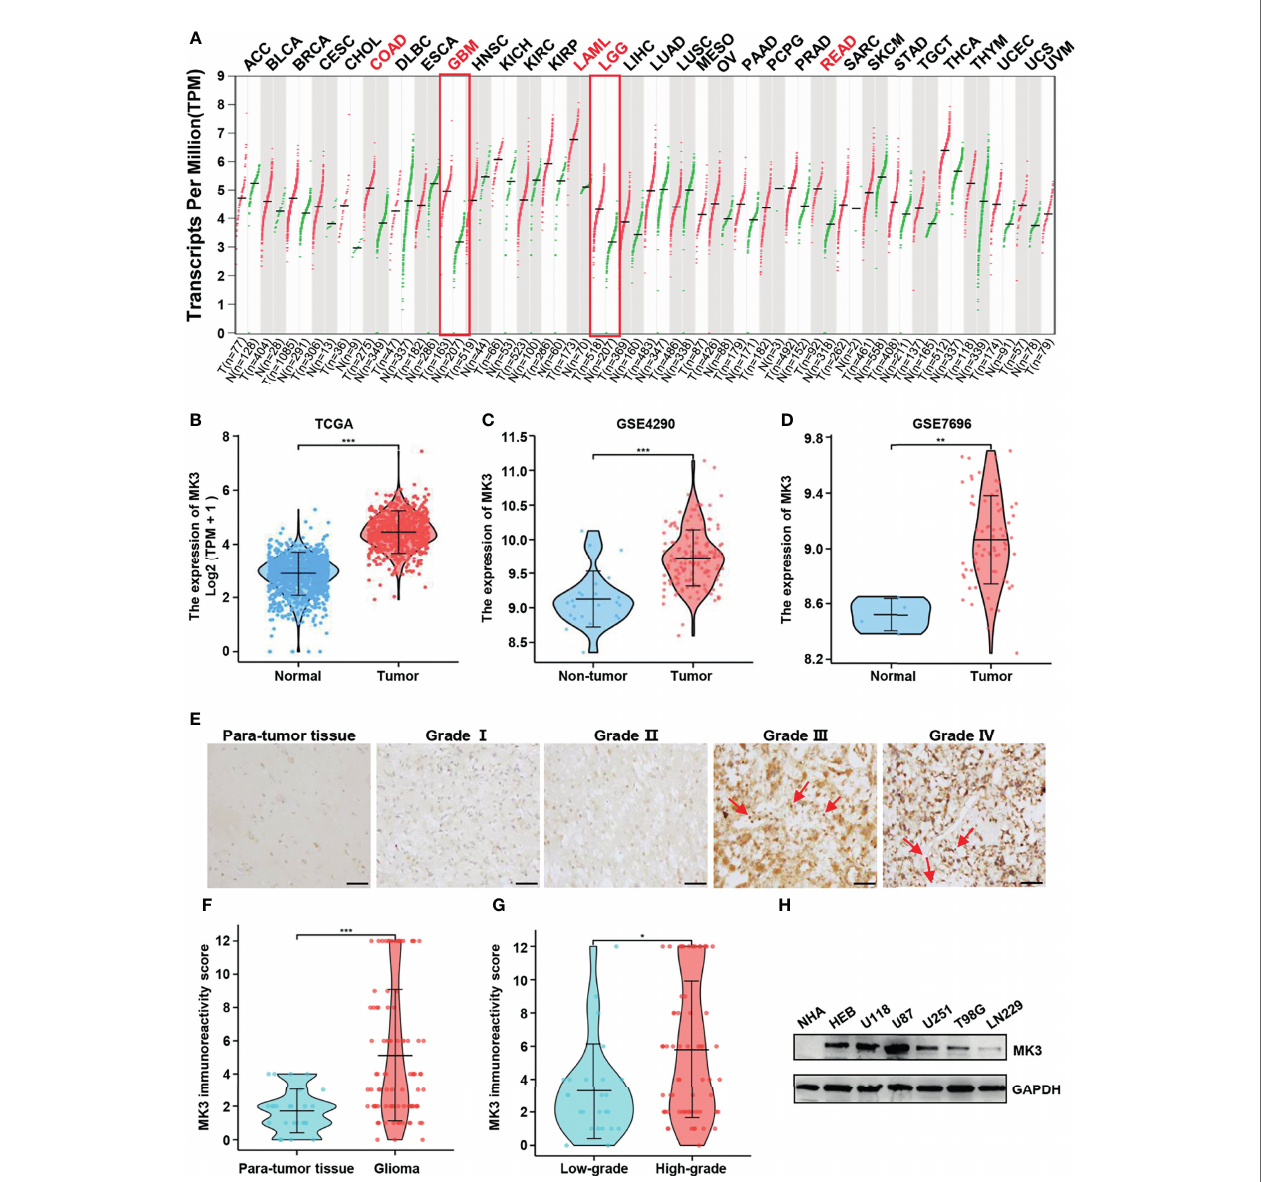
FIGURE 1 | MK3 was aberrantly upregulated in glioma. (A) MK3 mRNA expression in different normal human tissues and tumor tissues from TCGA and the GTEx projects. (B) Comparison of MK3 mRNA expression in GBM, LGG tissues ( n = 1,157), and normal brain tissues ( n = 689) from TCGA and GTEx databases. (C) Higher MK3 mRNA expression was observed in glioma samples compared with non-tumor samples in GSE4290 dataset. (D) Higher MK3 mRNA expression was observed in glioblastoma tissues compared with normal brain tissues in GSE7696 dataset. (E) The immunohistochemical staining of MK3 in human glioma specimens. Scale bar: 50 m m. Red arrows indicate the immune cells. (F) The MK3 immunoreactivity score of para-tumor tissues and glioma tissues. (G) The MK3 immunoreactivity score of low-grade and high-grade glioma tissues. (H) The protein expression levels of MK3 were examined in fi ve glioma cell lines, HEB, and NHA human astrocytes by Western blotting analysis. GAPDH was used as loading control. TCGA, The Cancer Genome Atlas; GTEx, Genotype-Tissue Expression; GBM, glioblastoma; LGG, low-grade glioma; HEB, human normal brain glial cells; NHA, normal human astrocyte. *p < 0.05, **p < 0.01, and ***p <